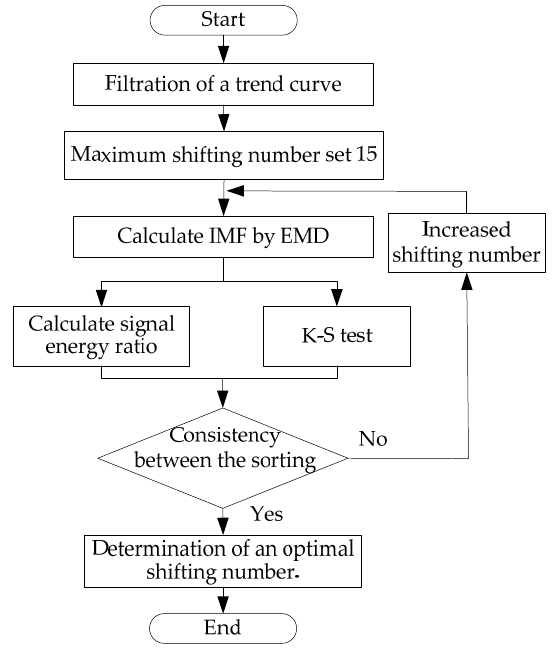
Figure 1. Flowchart for the determination of an optimal shifting number.